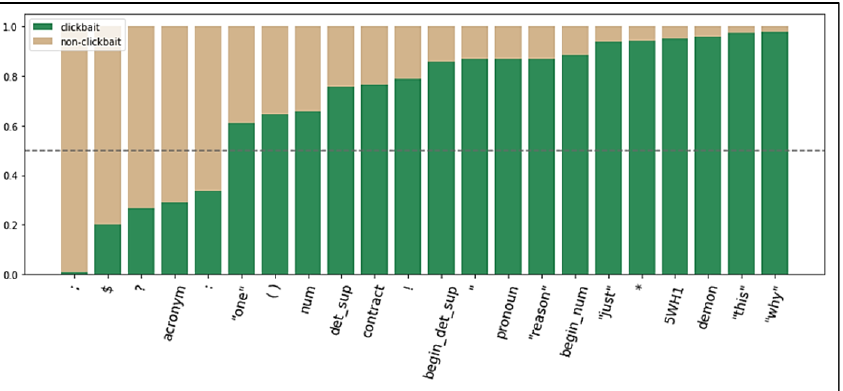
Figure 1. Stacked Bar Chart of Binary Feature Normalized Occurrence Rates in Clickbait Headlines.